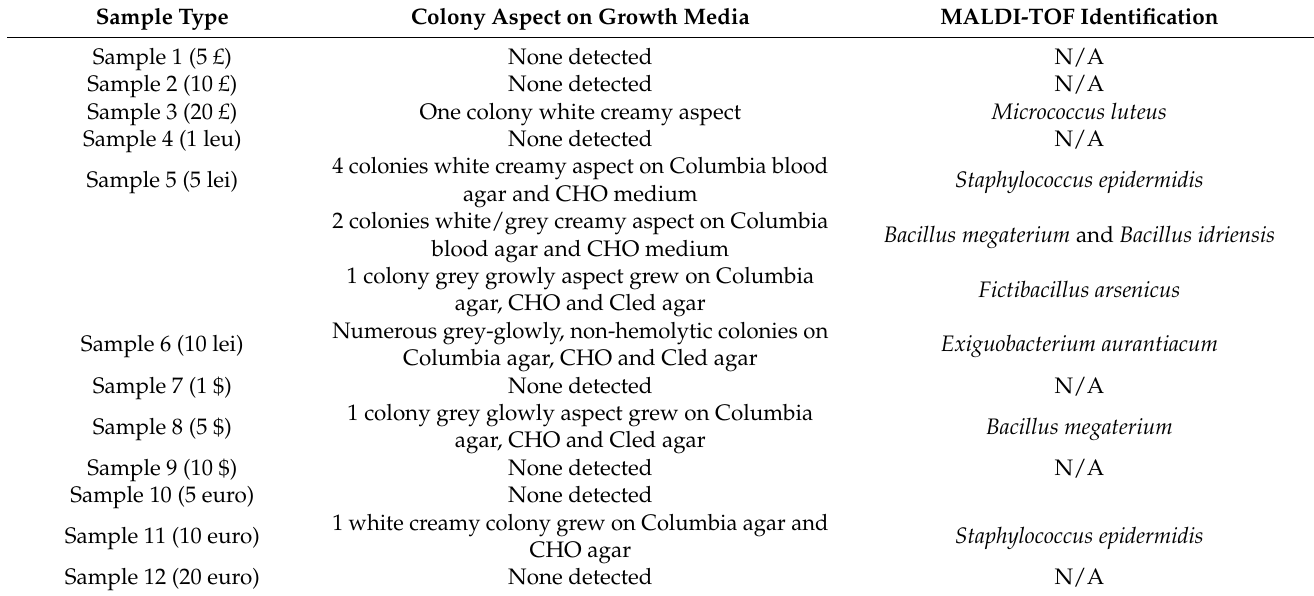
Table 1. Preliminary microflora